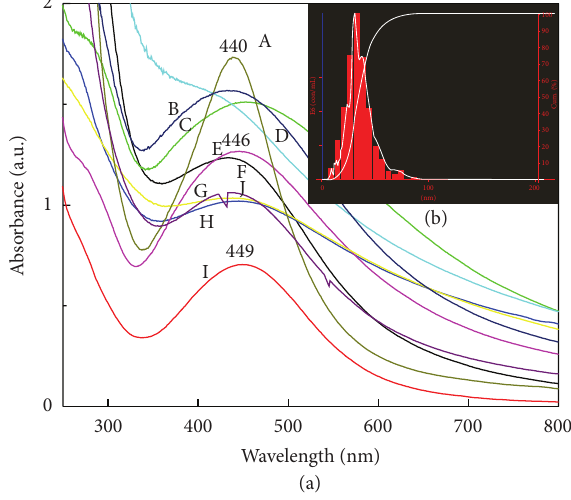
Figure 4: UV-Vis extinction spectroscopy of SNPs synthesized by growing fungus on different culture media—A: MGYP broth, B: PDB, C: lipase production medium, D: protease production medium, E. Sucrose peptone yeast broth, F: gluten glucose medium, G: Richard’s medium, H: czapek dox medium, I: glucose peptone yeast broth, and J: sabouraud broth. (Figure 4(a) spectra A)